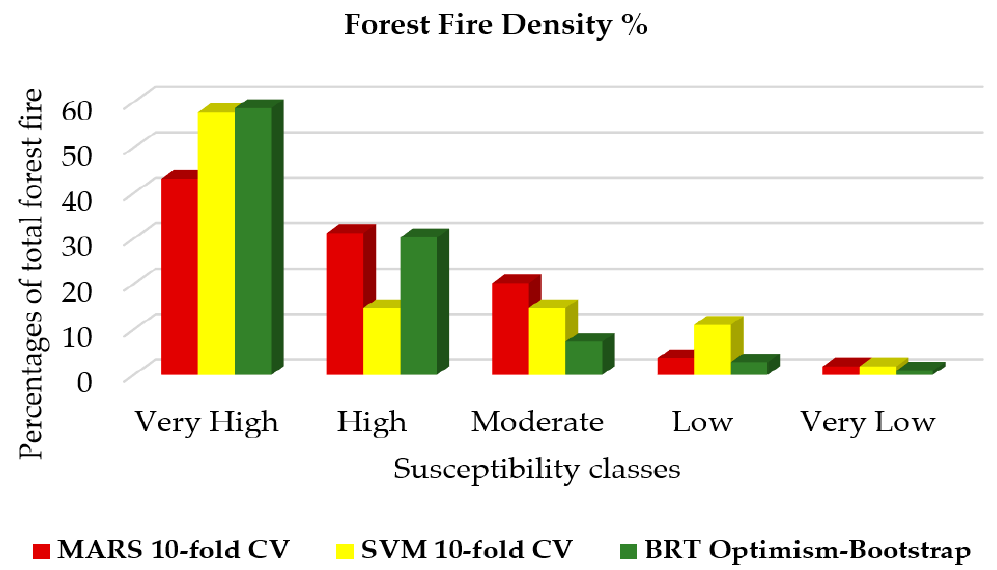
Figure 7. Forest fire density graph.